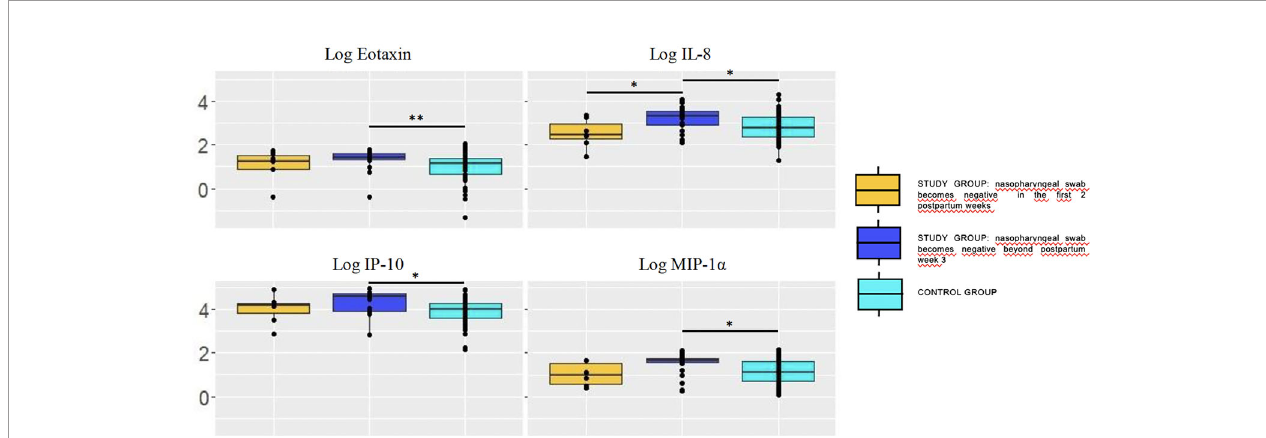
FIGURE 3 | Concentration (log) of chemokines in breastmilk of study group women according to the moment in which the nasopharyngeal test becomes negative (pooling samples obtained at weeks 1 and 5). Chemokyne concentrations were signi fi cantly higher in breastmilk samples of mothers whose RT-PCR remained positive at postpartum week 3 (dark blue box) compared with the control group. Trends also pointed toward higher concentrations in the former compared with those who became negative sooner, within the fi rst 2 postpartum weeks (yellow box). The values are expressed as log 10 of the concentrations (ng/L), with the exception of IP-10 ( m g/L). Statistical differences on pairwise post hoc comparisons between the study and control groups are indicated with an asterisk (*p < 0.05; **p ≤ 0.01; ***p ≤ 0.001, Wilcoxon rank test, Bonferroni post hoc test).